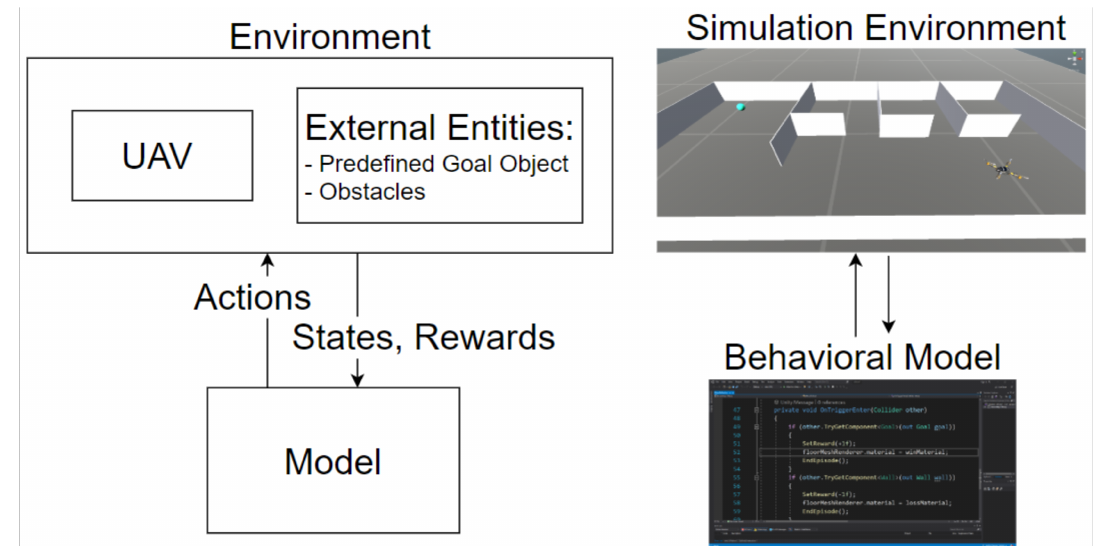
Figure 15. Learning